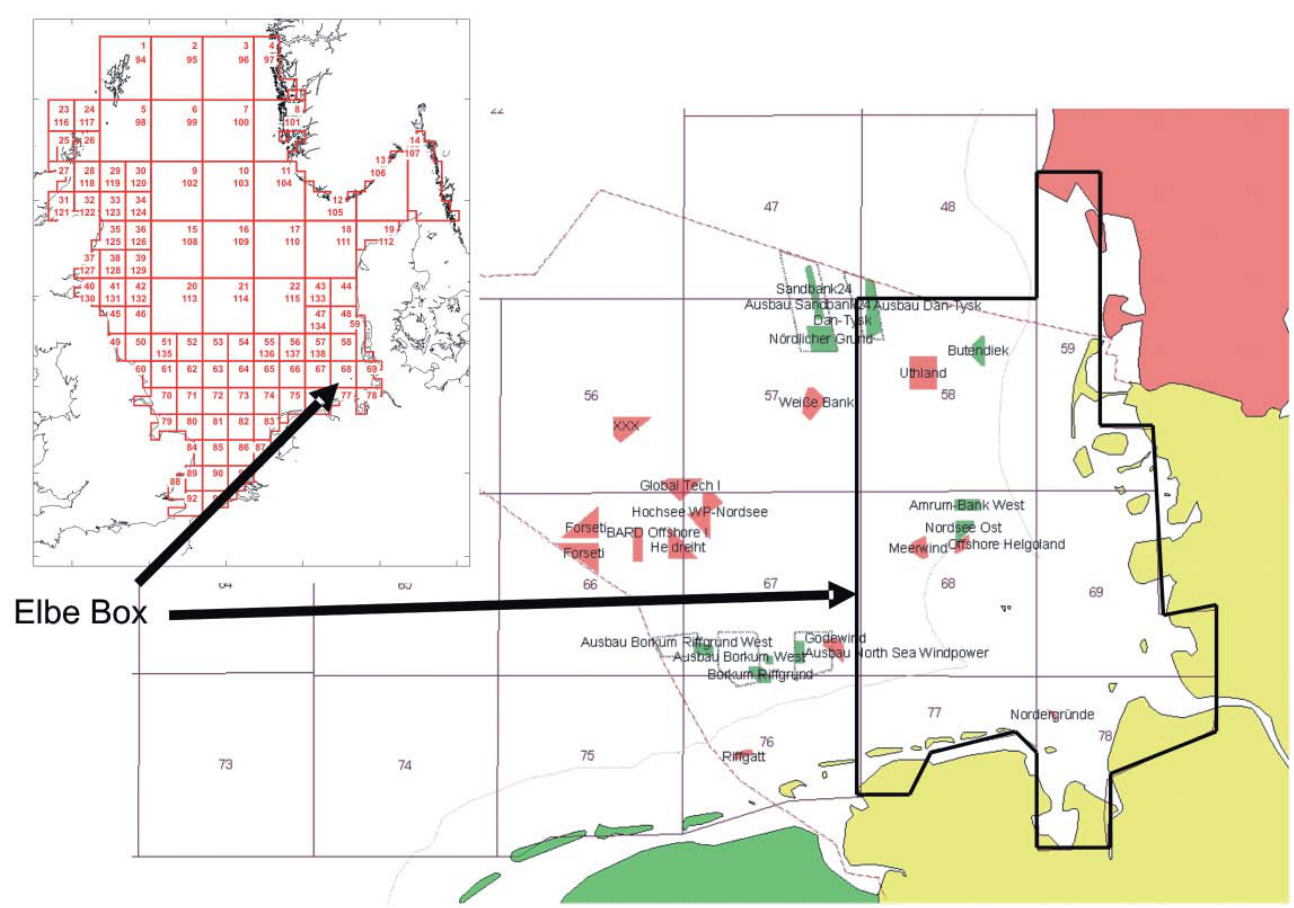
Figure 3. Study area: The Elbe-box is delimited by a bold line. In the German exclusive economic zone (EEZ) the wind farms included in the considered scenarios are